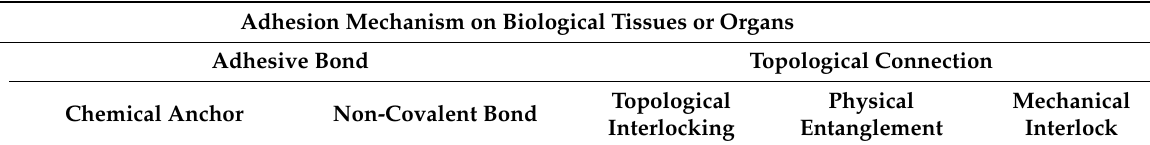
Table 1. Mechanisms of the adhesive materials for bonding the biological tissues or